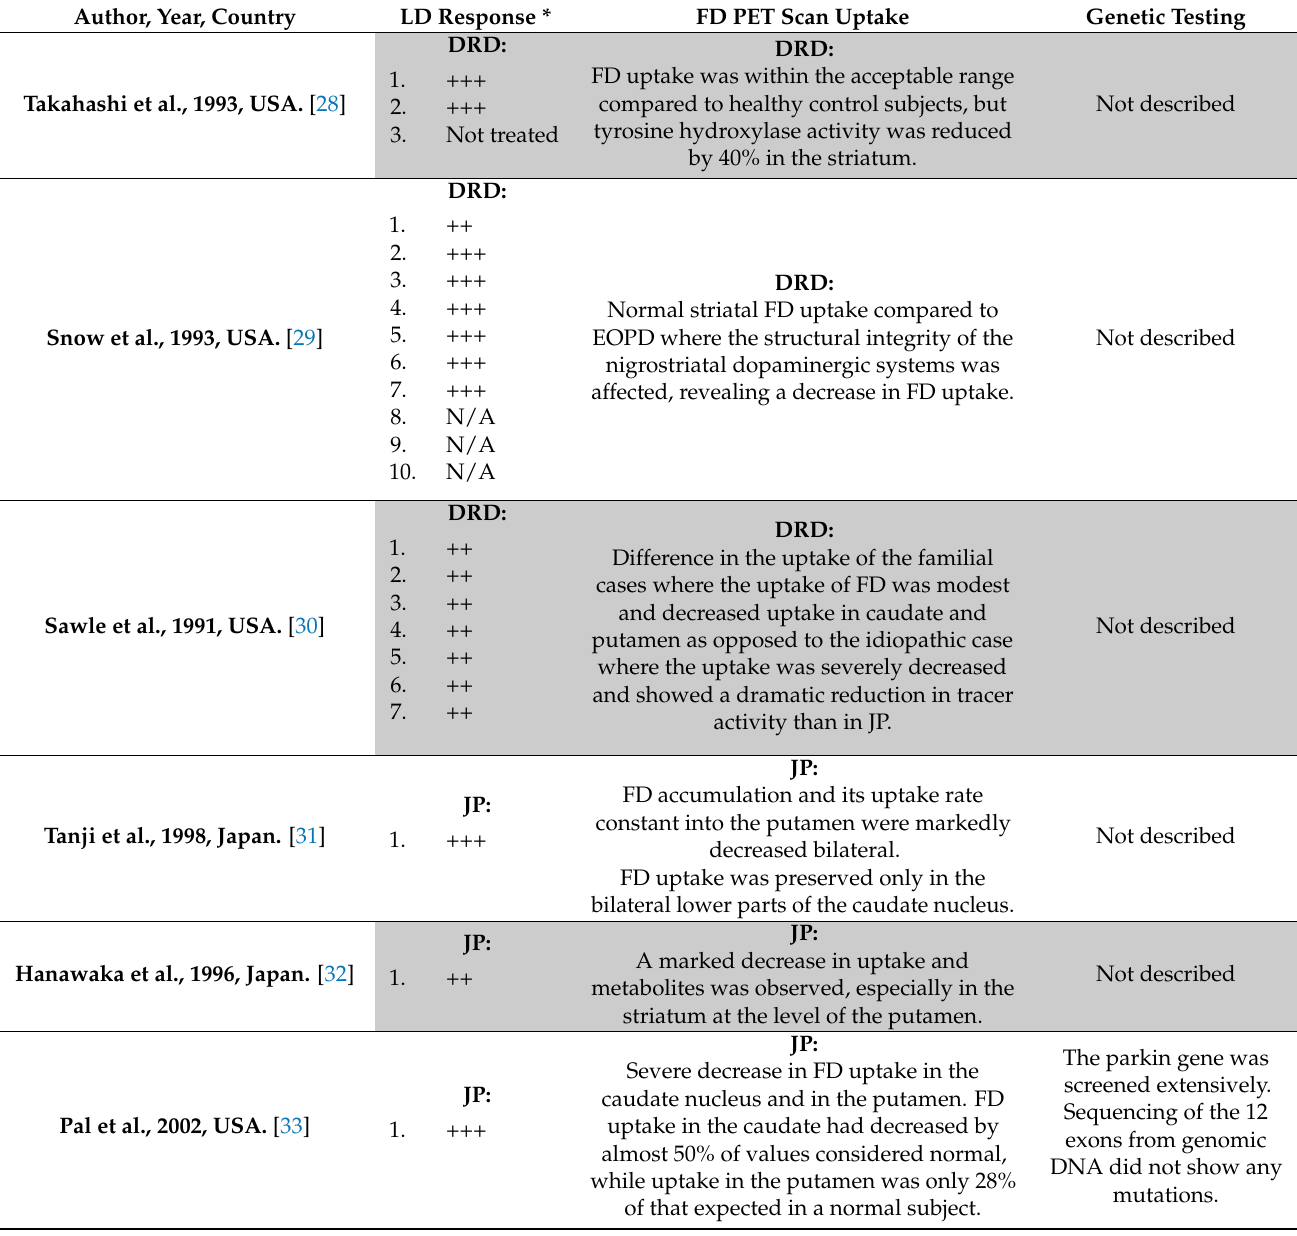
Table 4. Treatment, differences between FD PET Scans, and genetic testing of the case series.